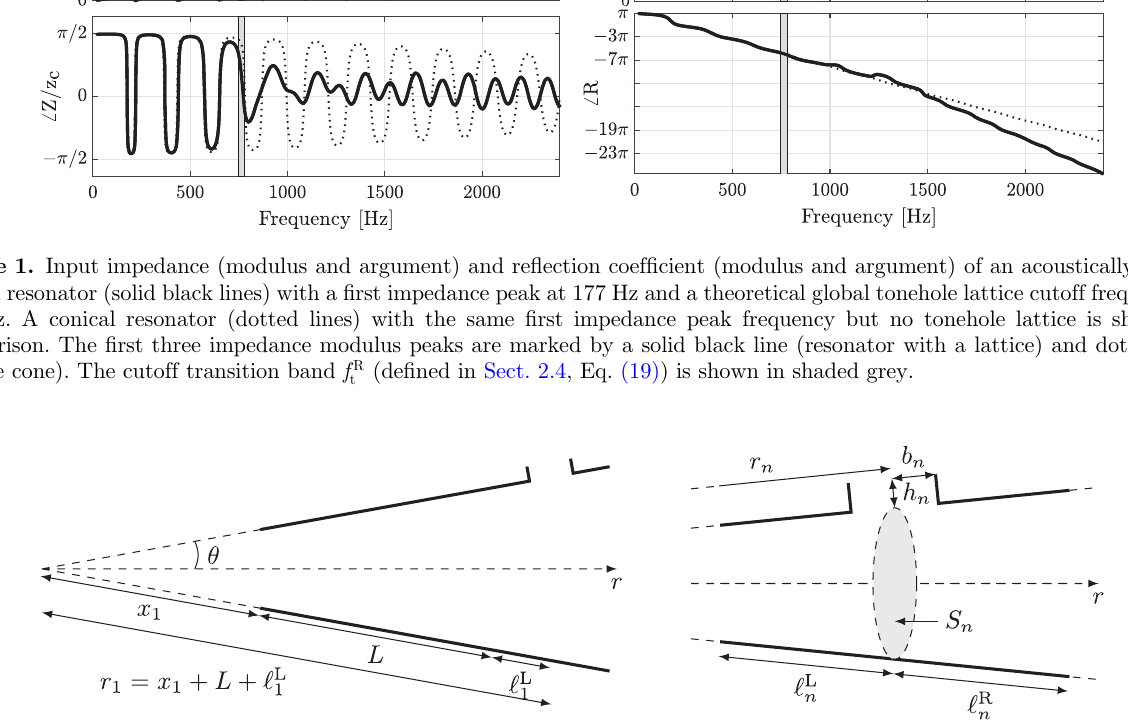
Figure 2. Schematic of a conical resonator with apex angle h and a lattice of toneholes. There is a length of duct L before the fi rst symmetric T-cell centered at r 1 (left panel). The missing length of the cone is x 1 . The n th T-cell, centered at r n , is fl anked by cones of length ‘ L and ‘ R on either side (right panel). The tonehole has cross-section s n = p b 2 n n main bore under the tonehole is S n